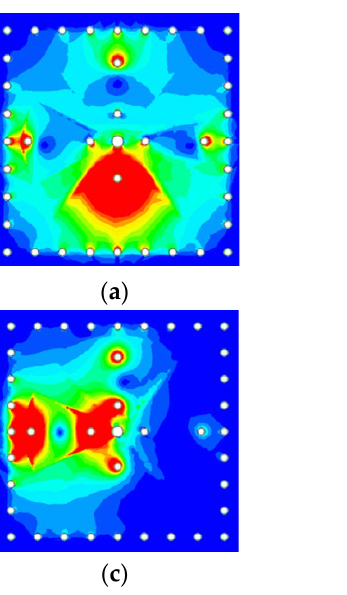
Figure 3. The electric field distribution on the top surface of metal layer M2 at the ( a ) first, ( b ) second, ( c ) third, and ( d ) fourth passband resonance frequencies.